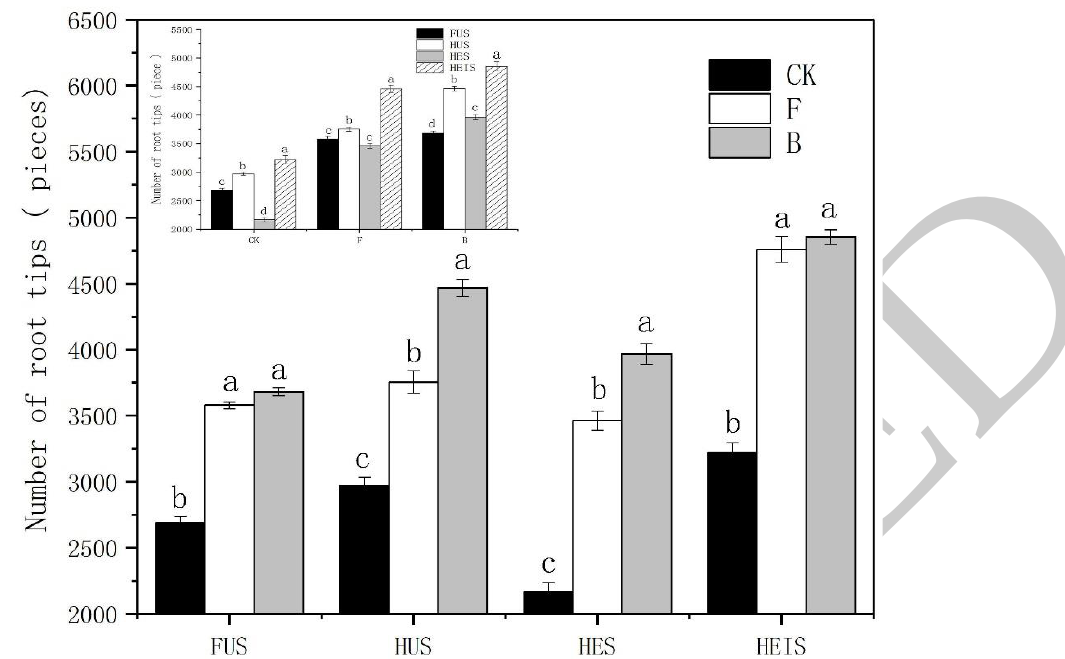
Figure 3. Effects of biochar on the number of tobacco plant root tips. Error bars represent the standard deviation from the mean, p > 0.05. CK: control treatment, F: treatment with nitrogen fertilizer, B: treatment with biochar.